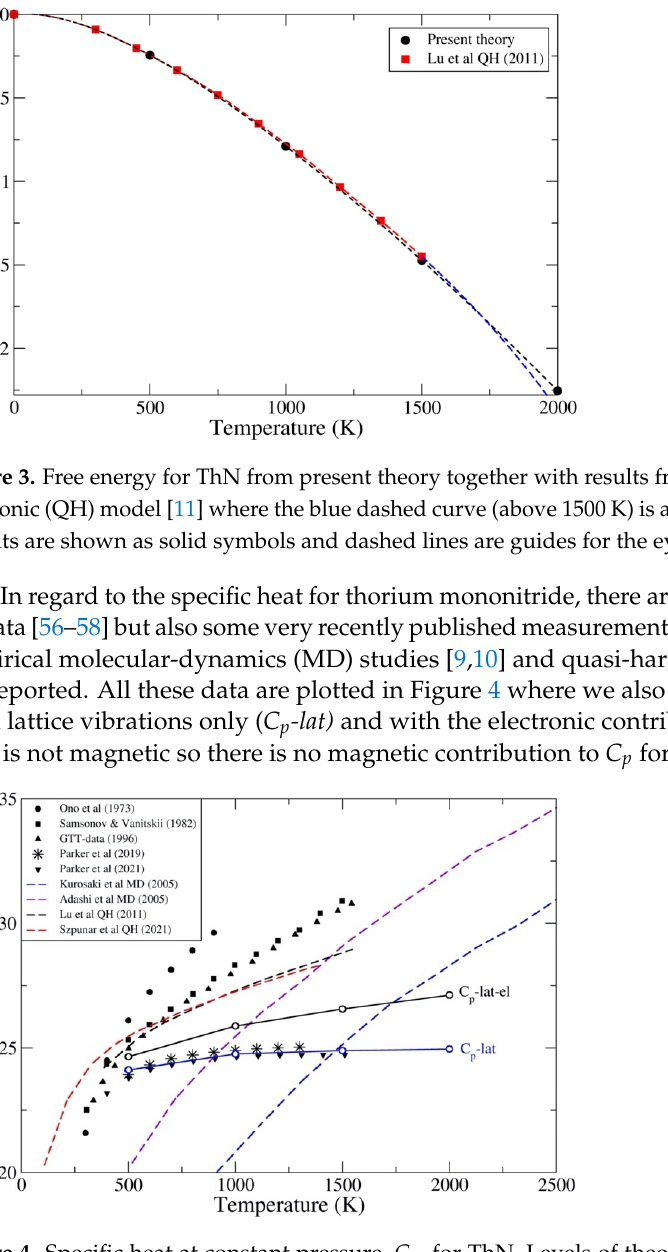
Figure 4. Specific heat at constant pressure, C p , for ThN. Levels of theory are open circles, where the connecting lines are guides for the eye only. The dashed lines refer to semi-empirical molecular- dynamics (MD) [9,10] and quasi-harmonic (QH) modeling [11,12]. Solid symbols are from experi- ments [6,7,56–58]. ments